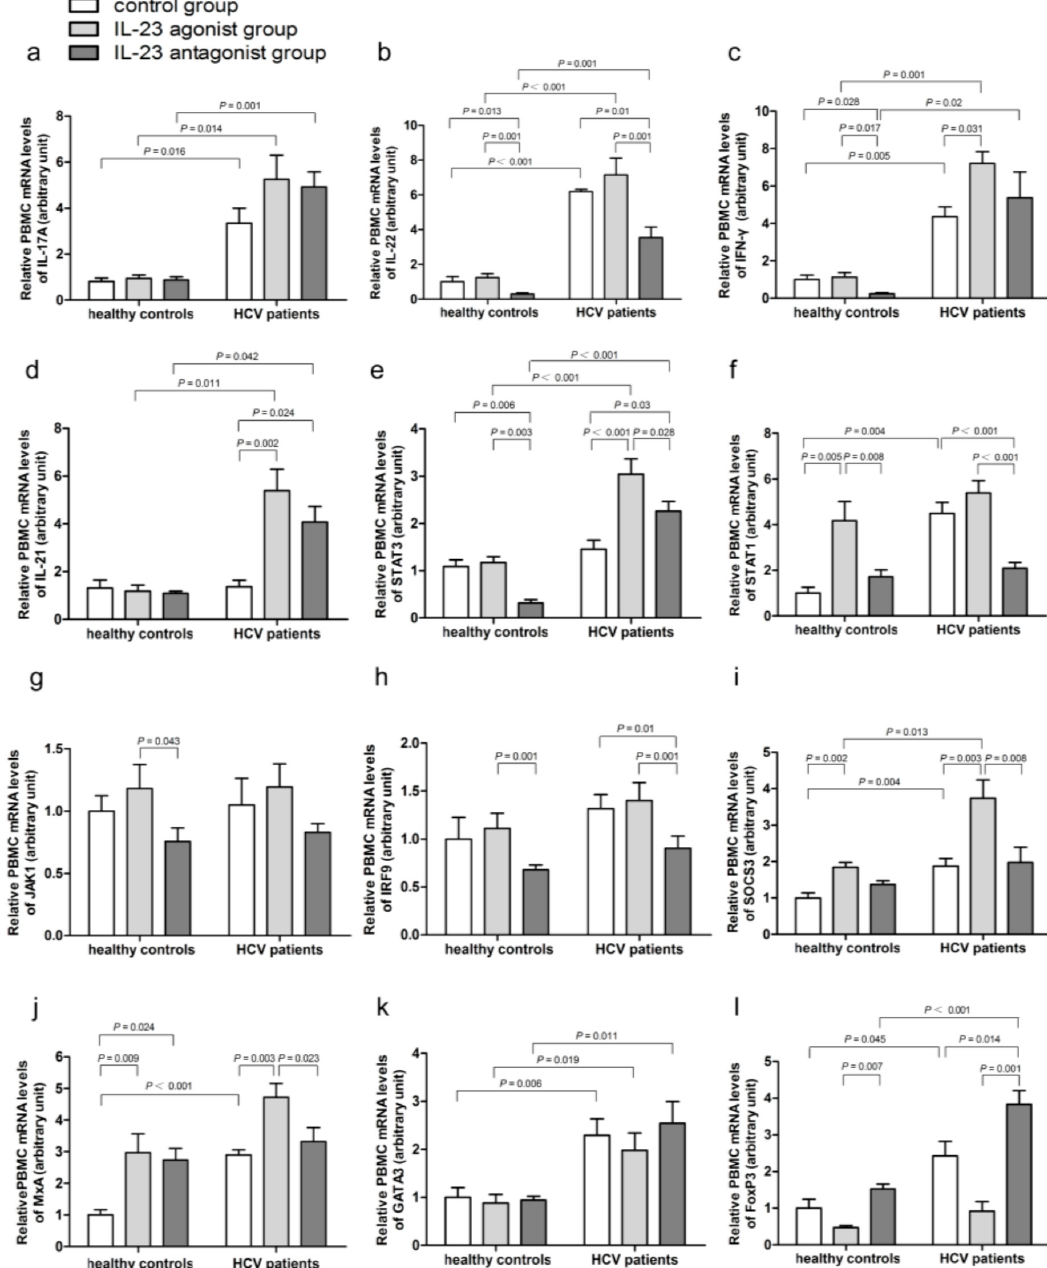
Figure 3. The expressions of IL-17A ( a ); IL-22 ( b ); IFN- γ ( c ); IL-21 ( d ); signal transducer and activator of transcription 3 (STAT3, ( e )); STAT1 ( f ); Janus kinase 1 (JAK1, ( g )); interferon regulatory factor 9 (IRF9, ( h )); suppressor of cytokine signaling 3 (SOCS3, ( i )); myxovirus resistance protein A (MxA, ( j )); GATA binding protein 3 (GATA3, ( k )); and forkhead box P3 (FoxP3, ( l )) in the PBMCs from healthy controls ( n = 15) and patients with chronic HCV infection ( n = 24) were examined by real-time quantitative reverse transcription polymerase chain reaction (qRT-PCR). Data are expressed as mean ± SD.